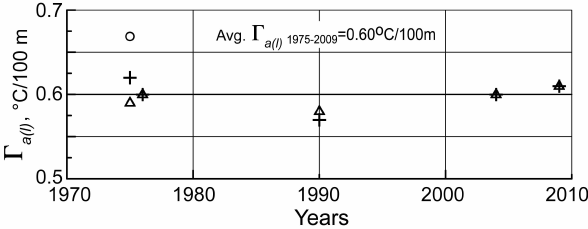
Fig. 3. LARISSA Site Beta altitudinal lapse rate calculated with respect to the Faraday/Vernadsky (crosses) and Rothera (triangles) weather stations; circle is Detroit Plateau mean